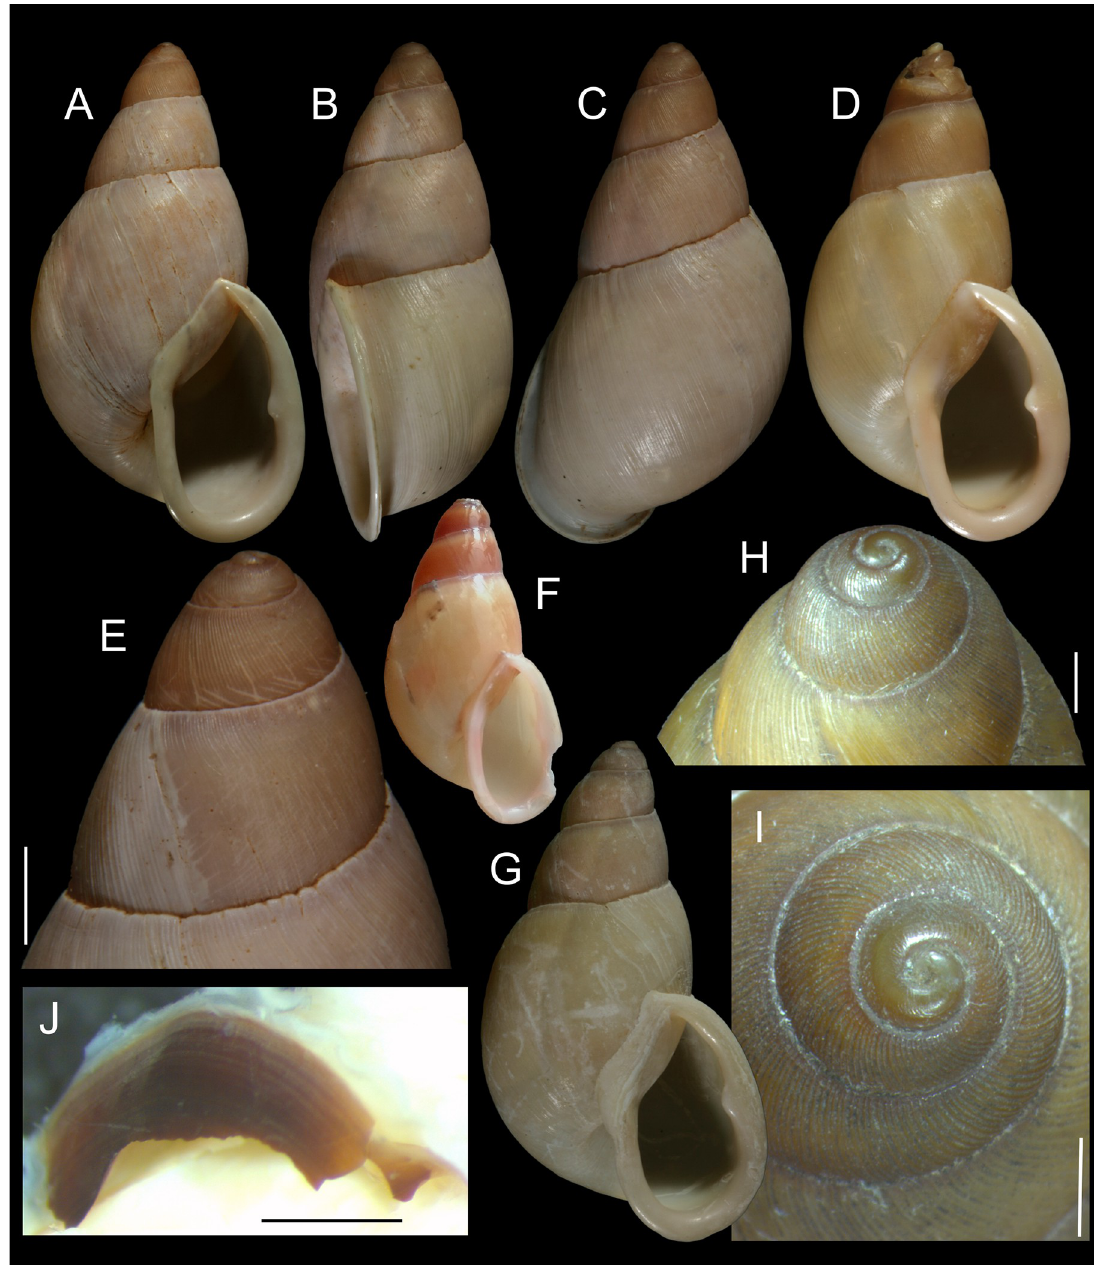
Fig 20. Catracca uhlei , shells and jaw. (A-C) Holotype MZSP 151900 (L 44.2 mm). (A) Frontal view. (B) right view. (C) dorsal view. (D) Paratype MZSP 151901#1 (L 42.8 mm), frontal view; (E) holotype protoconch in profile, scale = 3 mm. (F) paratype 151893, shell of one of dissected specimens, frontal view (L 47.1 mm). (G) Paratype MZSP 151901#2 (L 43.0 mm). (H) Paratype MZSP 151871, young specimen, detail of apex, profile-slightly apical view, scale = 2 mm. (I) Same, apical view, scale = 2 mm. (J) Jaw plate, ventral view (slightly broken in left end, right in Fig), scale = 1